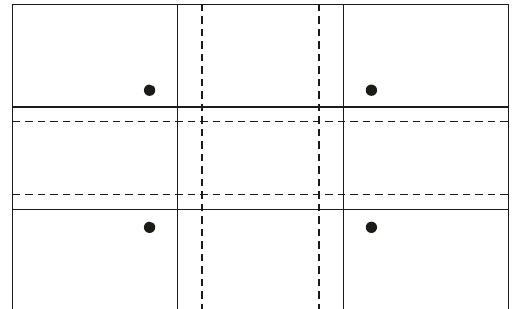
Figure 4: The shrinkage points, trisection lines (solid lines), and golden lines (dashed lines) of a golden rectangle. O comparison, we display the trisection lines and the golden lines of the same golden rectangle. The golden lines divide the width or the height at the golden ratio. These dots and lines are important references for drawing and photography.